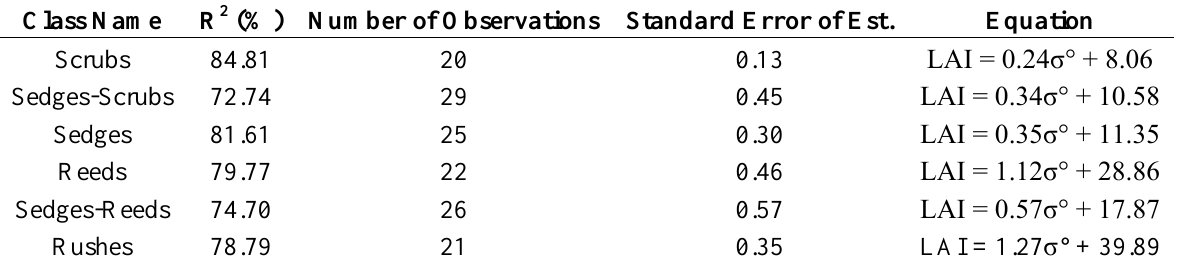
Table 6. Results of the statistical analyses between LAI and σ° at a 95% confidence